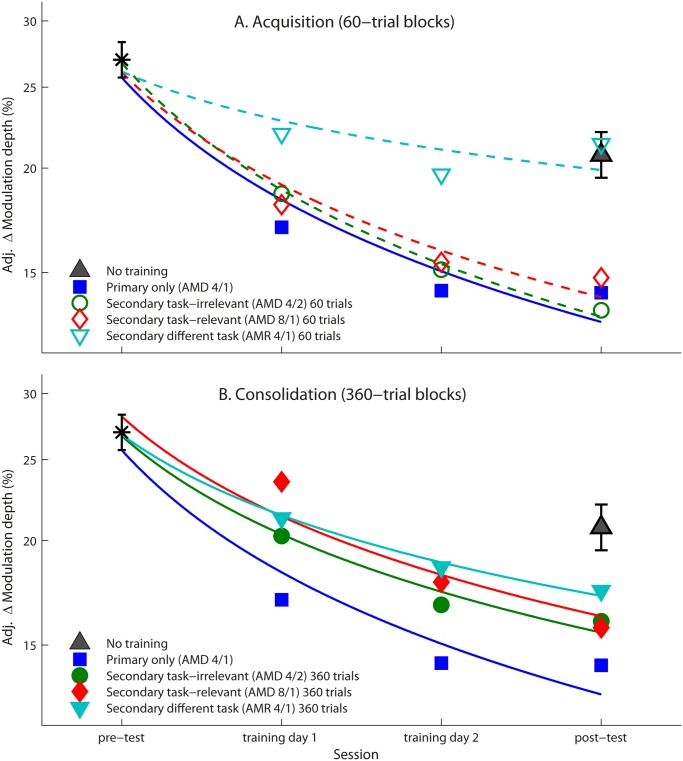
Performance on the primary (AMD 4/1) task.Mean thresholds across the 6 blocks comprising each daily session for primary task-only (blue squares), secondary task-irrelevant (green circles), secondary task-relevant (red diamonds), and secondary different task cue (cyan triangles) training groups during (A) acquisition (unfilled markers) and (B) consolidation (filled markers). Here (and in all subsequent figures) displayed thresholds were adjusted to account for individual variation in pre-test thresholds (on each task), equivalent to using the pre-test thresholds as covariates in an ANCOVA of the post-test thresholds (see [27,28]). The star marks the mean pre-test threshold calculated across the entire sample. Regression lines (dashed for acquisition and continuous for consolidation) were fitted to the log of the session number. The adjusted post-test threshold of the no-training controls is provided as a grey filled triangle. Error bars (here and in subsequent figures) indicate ±1 standard error of the mean.